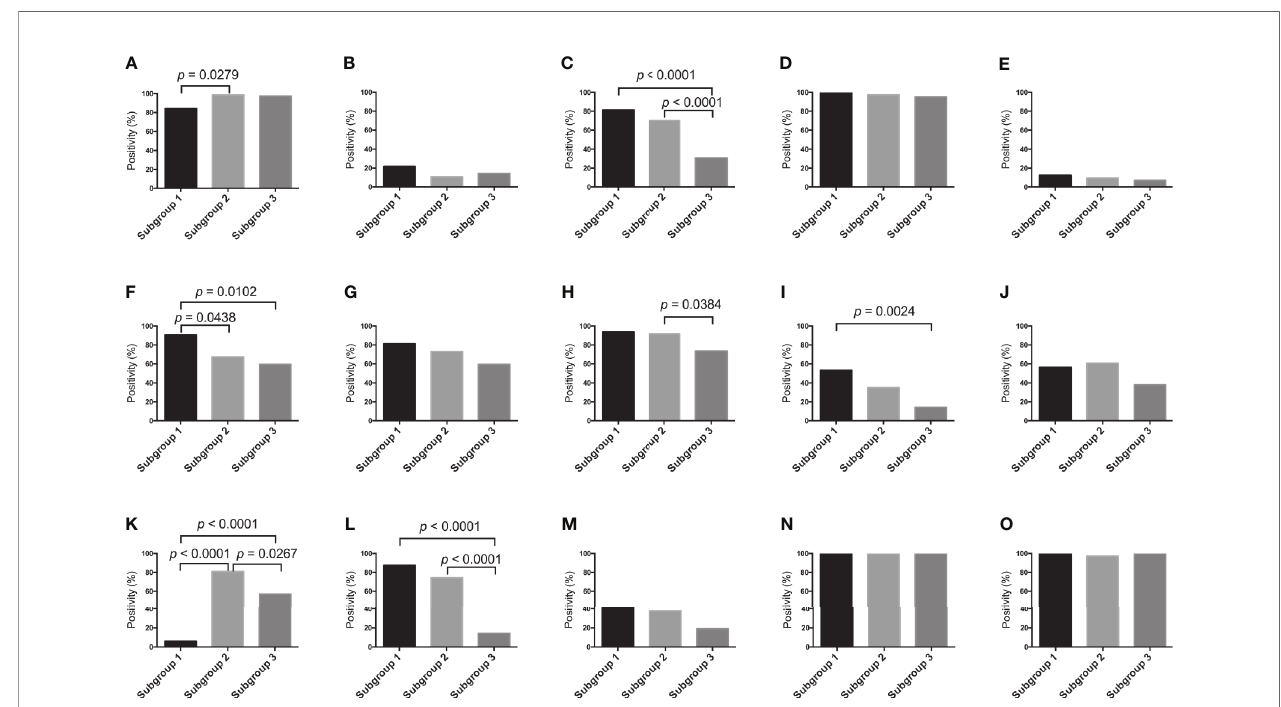
FIGURE 3 | Marker expression levels. (A) Expression level of each marker in the fi rst cohort. (A) a -SMA, (B) CD10, (C) Podoplanin, (D) FSP1, (E) FAP, (F) Tenascin- C, (G) PDGFR- b , (H) ZEB1, (I) TWIST, (J) Ki-67, (K) p53, (L) MMP7, (M) b -catenin, (N) E-cadherin and (O) HIF1- a